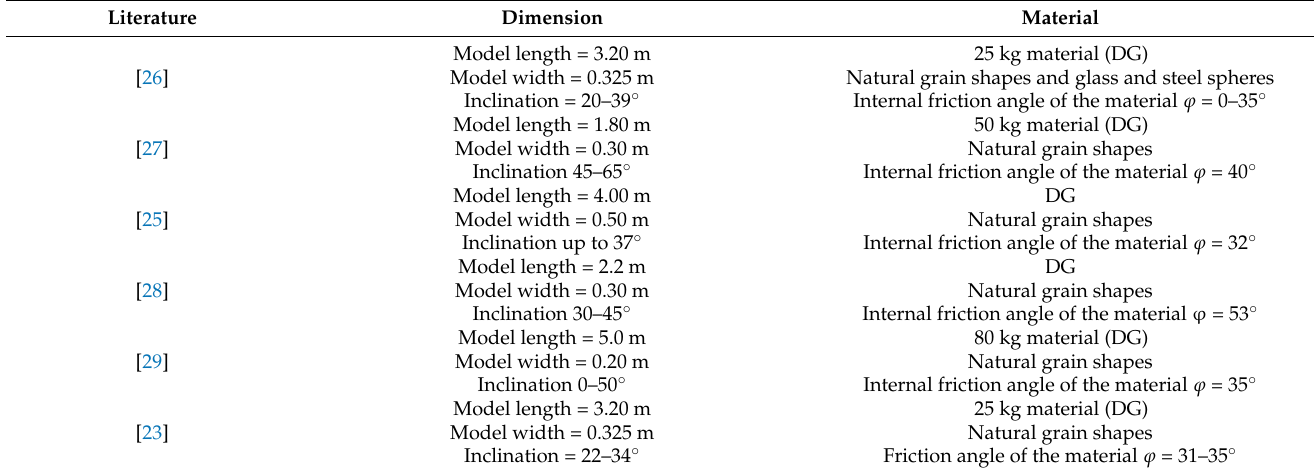
Table 1. Examples of model tests performed to study gravitational mass